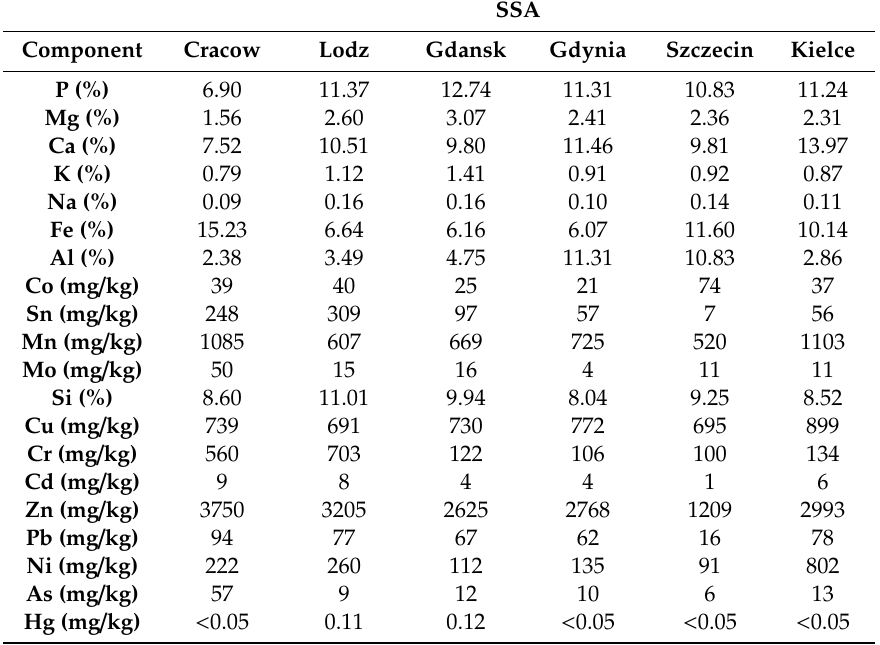
Table 3. Elemental composition of the SSA from the mono-incineration plants and the SS used in the